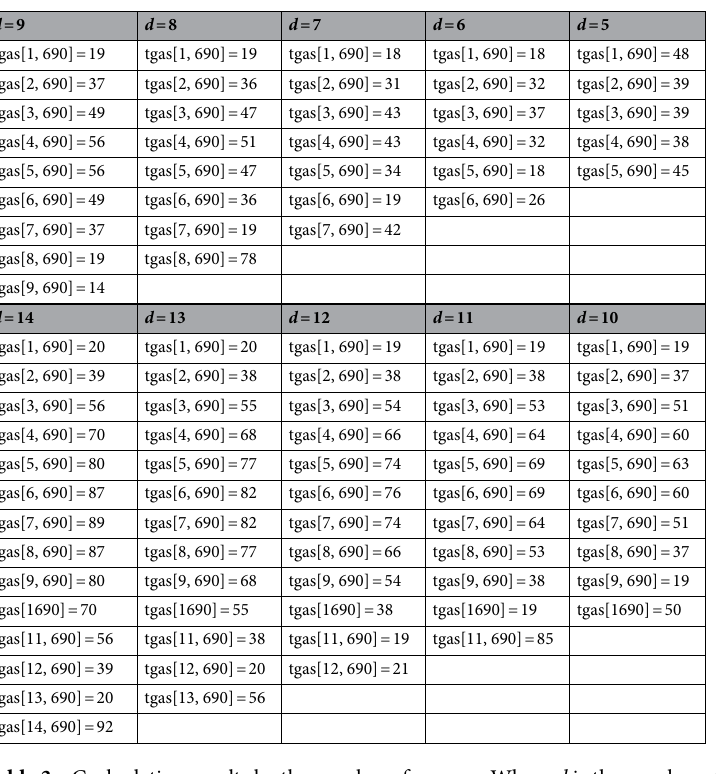
Table 3. Ccalculation results by the number of sensors. Where d is the number of input elements (coolers) for